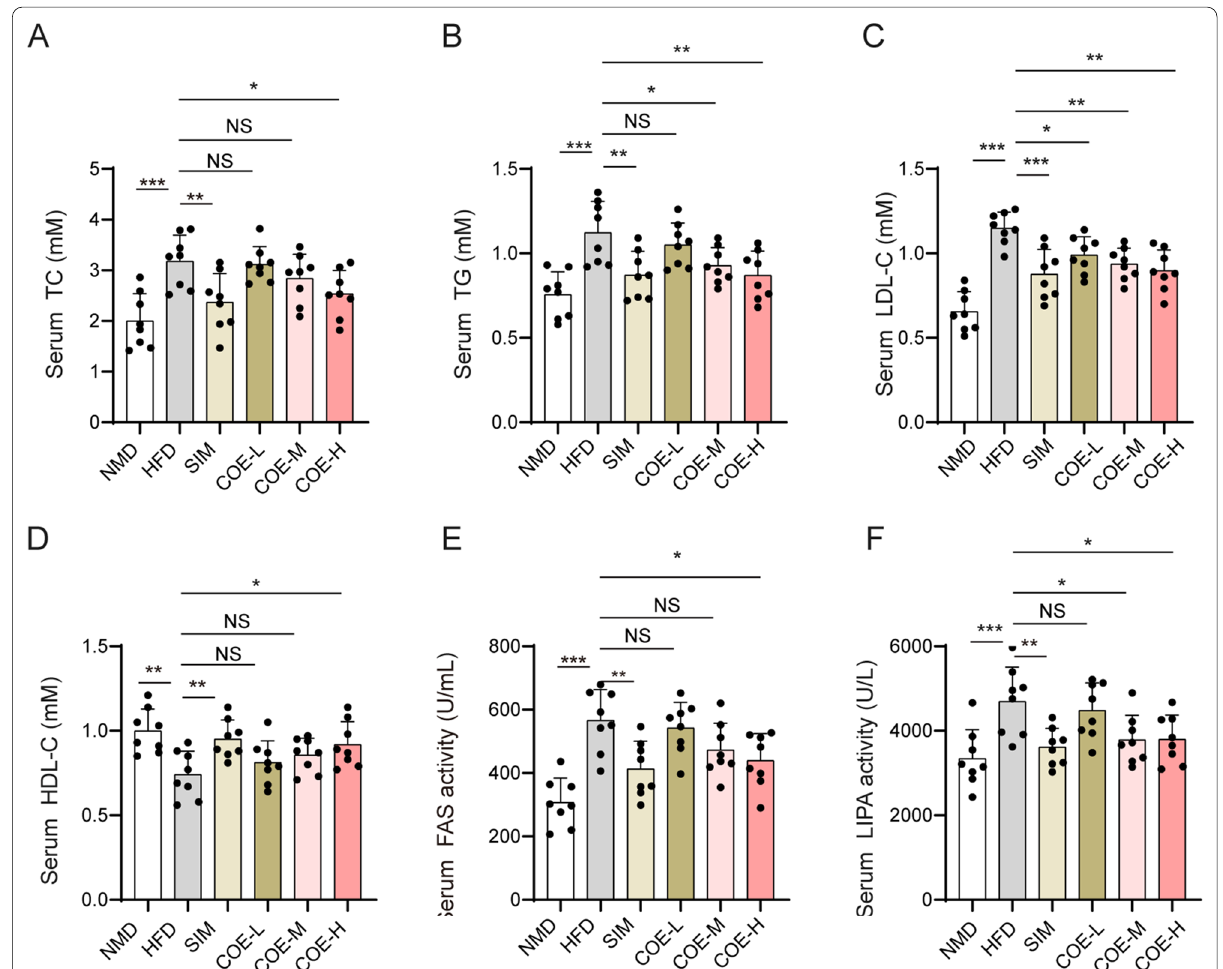
Fig. 2 Effects of COE on lipid levels and lipase activities in the serum of hyperlipidemic rats. TC ( A ), TG ( B ), LDL-C ( C ), HDL-C ( D ), FAS ( E ), and LIPA ( F ) levels in the serum of hyperlipidemic rats were measured after COE or SIM treatment.